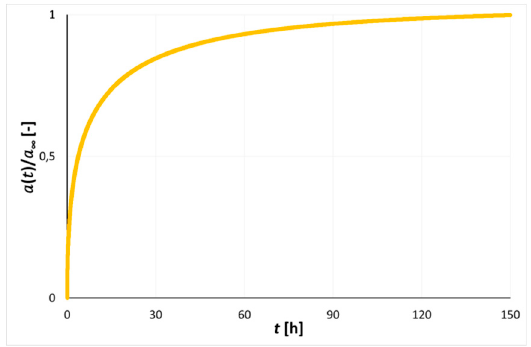
Figure 7. Methane sorption kinetics after normalisation of the adsorbed amount (high-rank coal 4030).